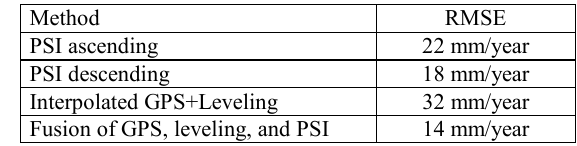
Table 2. Comparison between estimated vertical results and validation